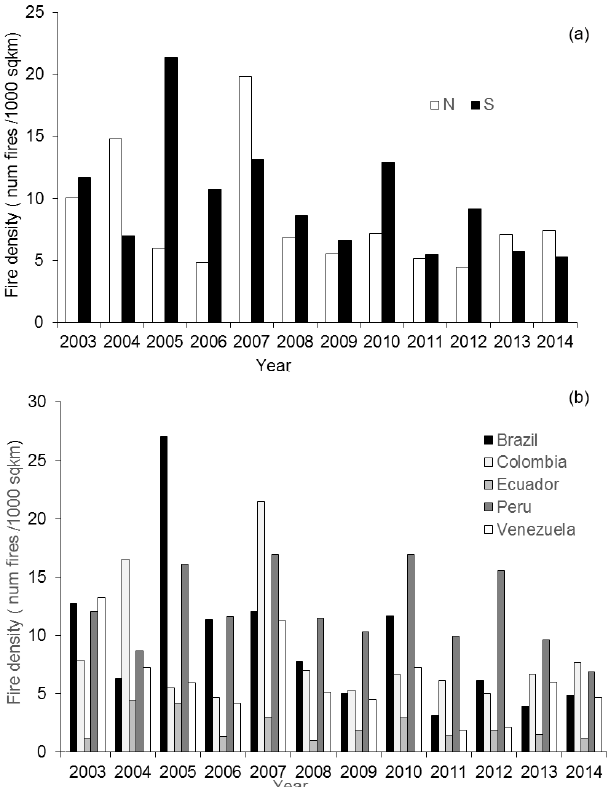
Figure 2. Interannual variability of satellite-detected active-fire density (number/1000sqkm) per latitudinal position (north, south) (a) and country (b)